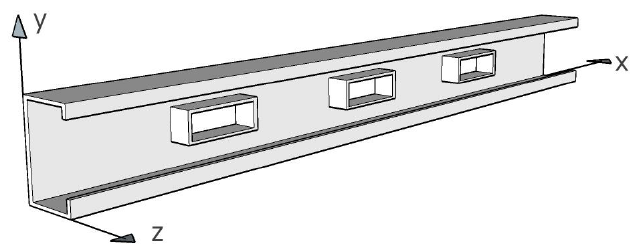
Figure 6. CFS channel beam with multiple edge-stiffened rectangular openings.